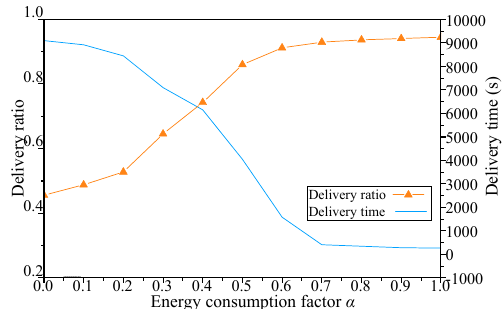
Figure 11. Influence of α on message delivery ratio and delivery time.